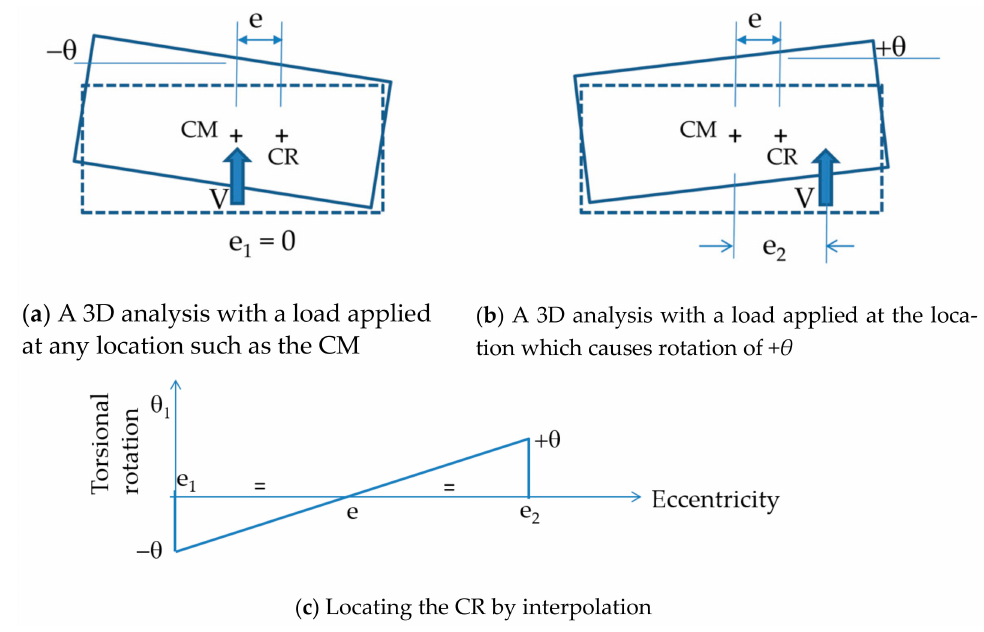
Figure 5. Method 3 of locating the CR based on 3D analyses and